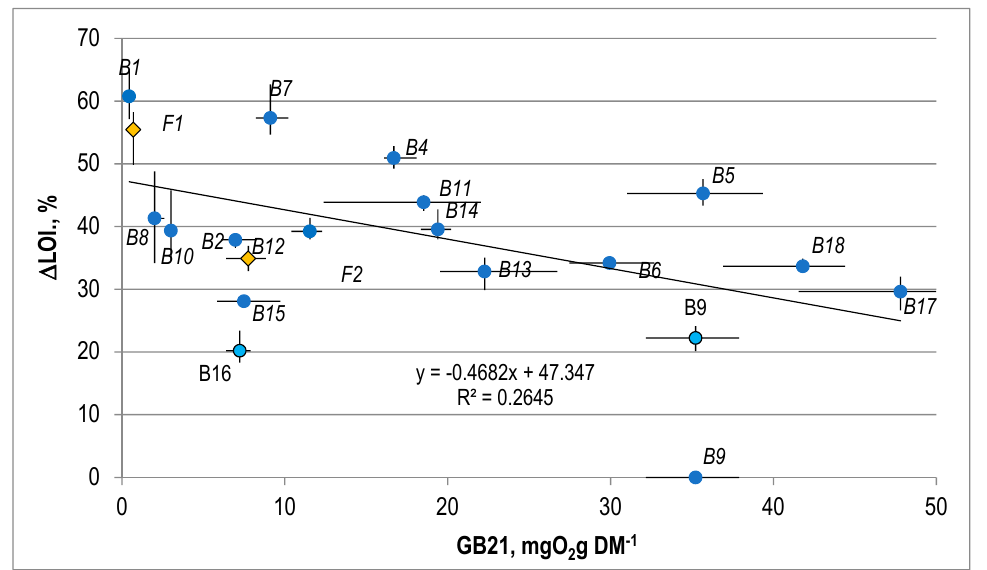
Figure 5. The correlation between the LOI and the AT4 for the stabilized waste.